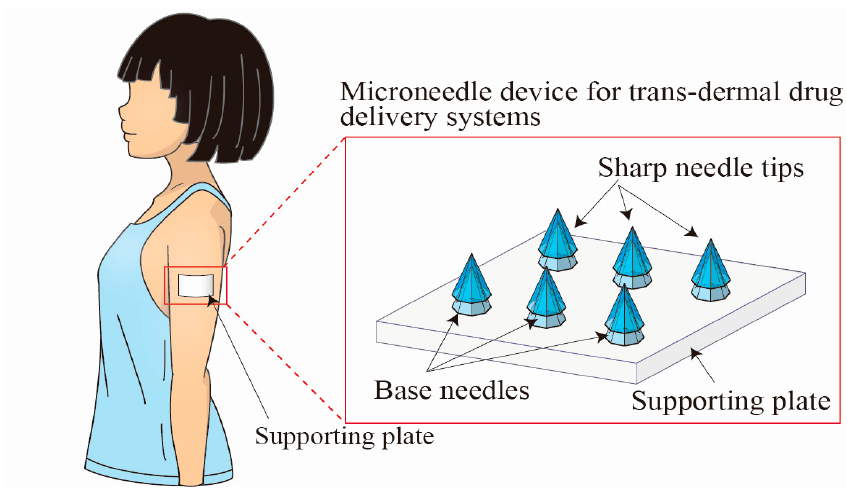
Figure 1. Tip-separable microneedle device for trans-dermal drug delivery systems.